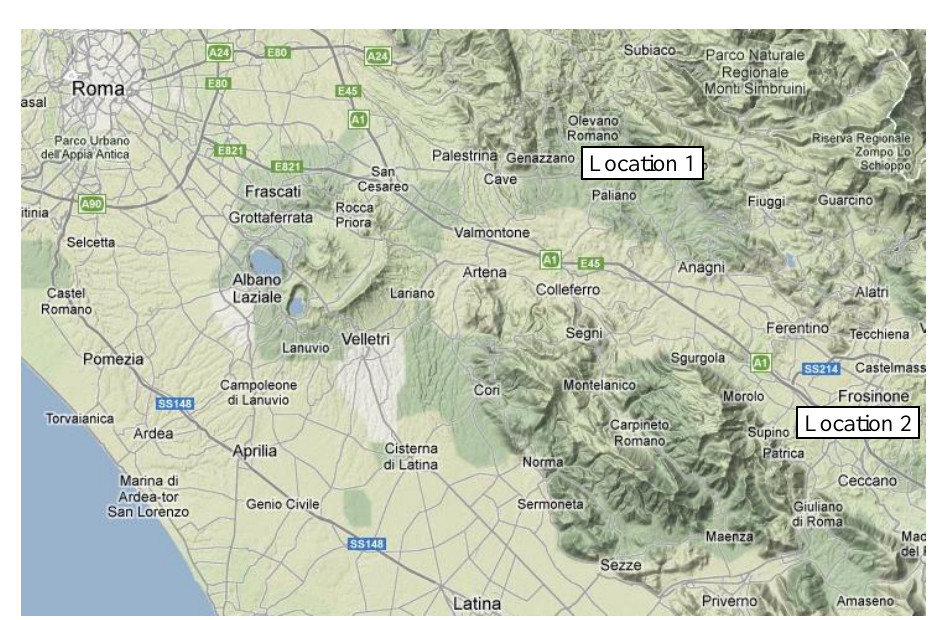
Figure 4. Map for localizing the area of study.